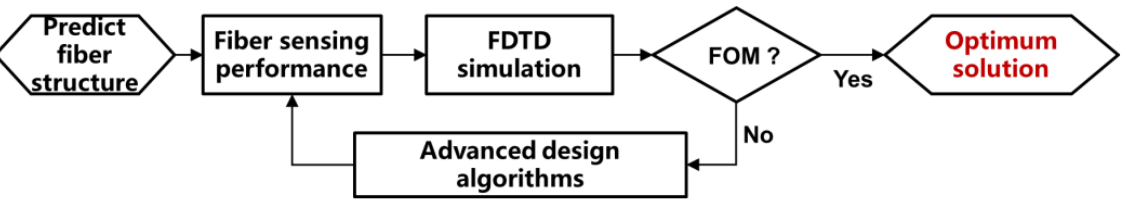
Figure 7. Schematic diagram of the advanced design of optical fiber microstructures.